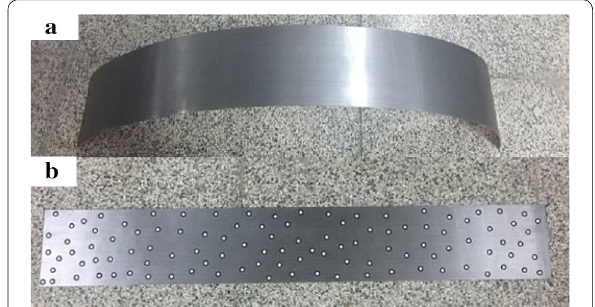
Figure 9 Experimental plate: ( a ) Before leveling; ( b ) After leveling